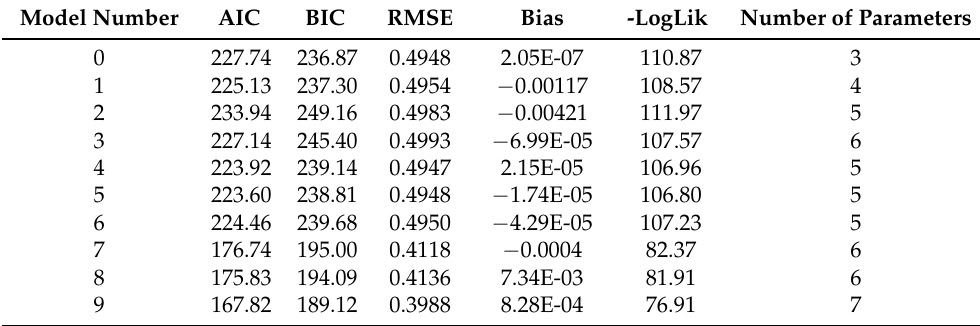
Table 3. Associated fit statistics and evaluation criteria for the models evaluated using the training data (n =